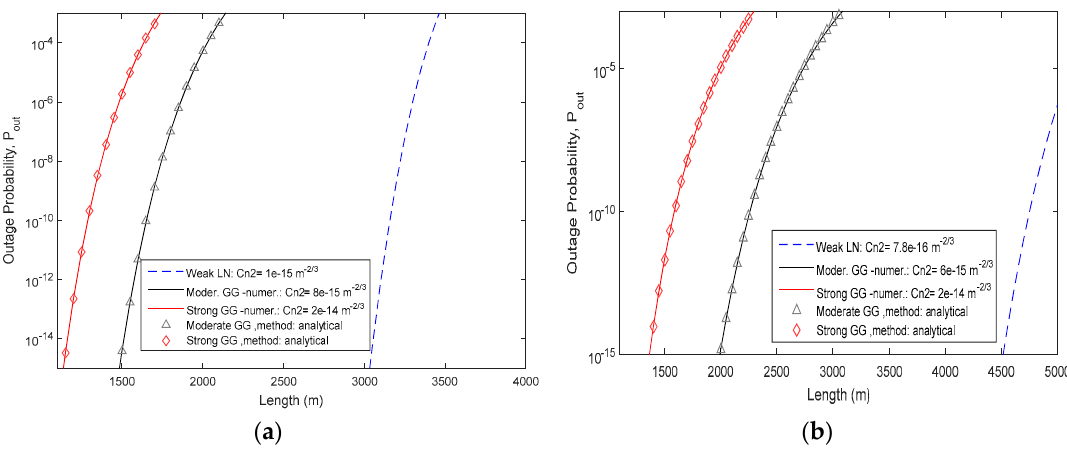
Figure 3. Outage probability estimation, with the proposed computational tool for weak to strong turbulence conditions, ( a ) for links up to 4 km with receiver threshold set as − 30 dBm; ( b ) for total link length up to 5 km with receiver threshold set as − 40 dBm. These results use the lognormal or the gamma–gamma distribution as mentioned in the plot legend.